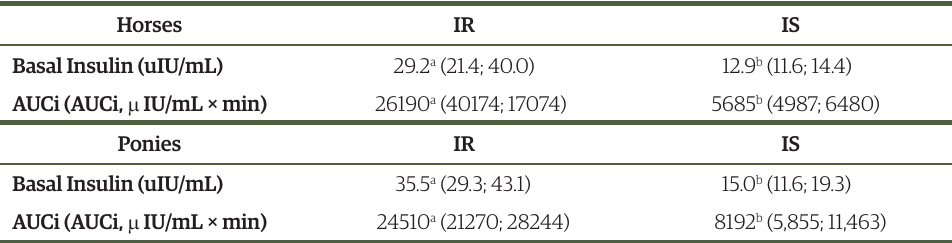
Table 1. Values of basal insulin and area under the insulin curve for insulin resistant versus insulin sensitive horses and ponies.